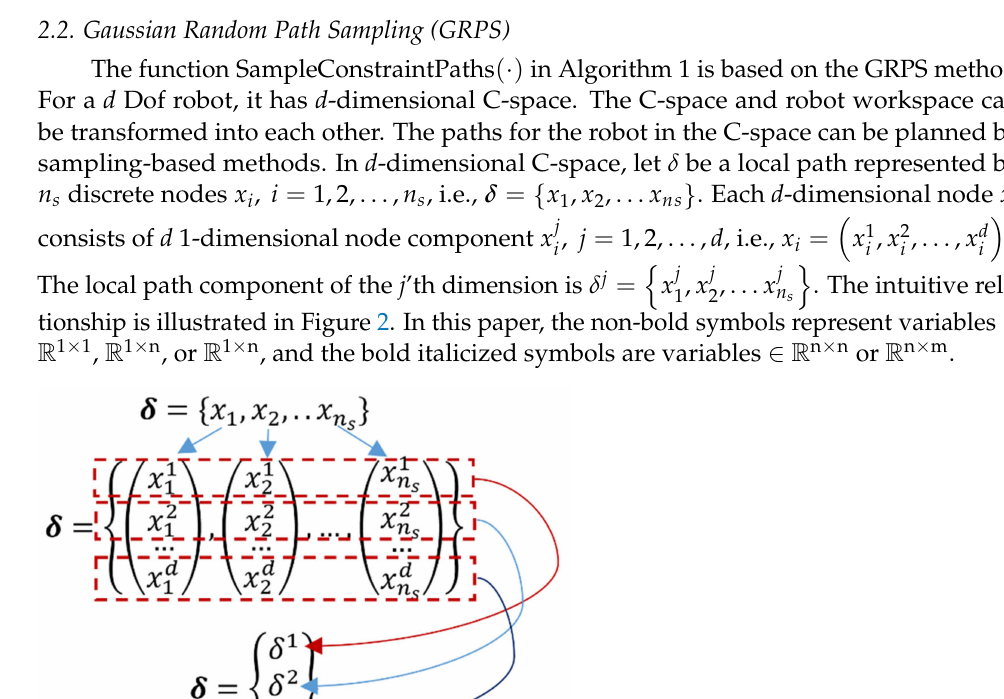
, local path δ , and local i